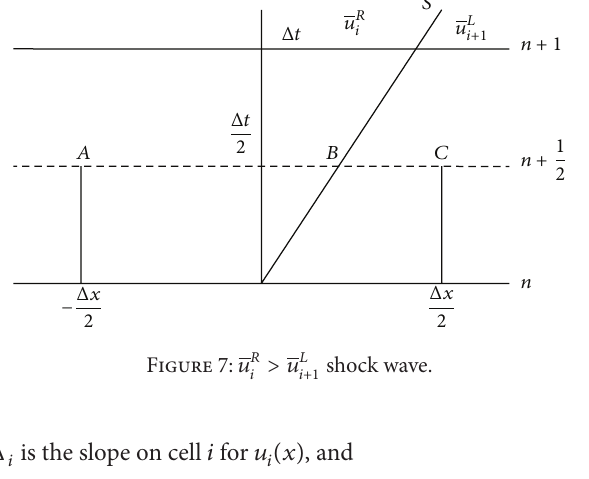
Figure 7: 𝑢 𝑅 𝑖 > 𝑢 𝐿 𝑖+1 shock